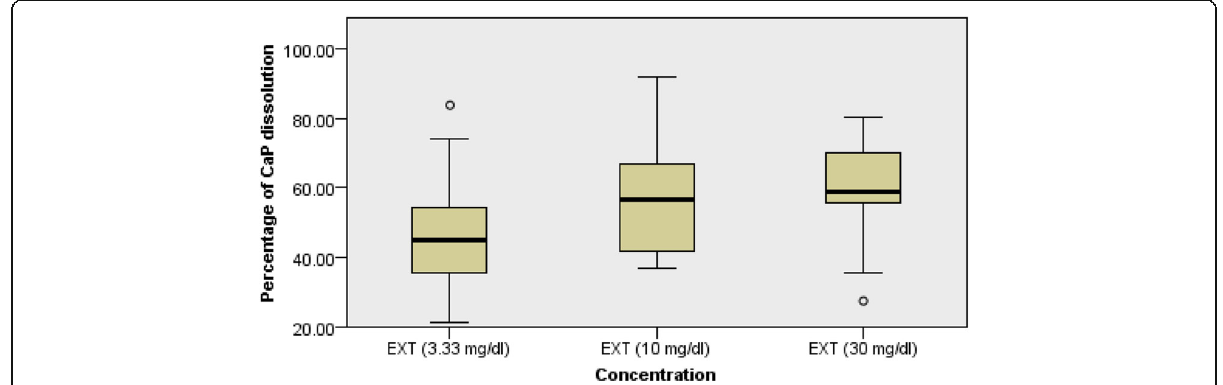
Fig. 4 Percent dissolution of phosphat calcium (CaP) based on extract concentration